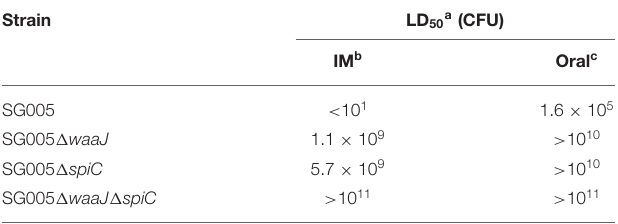
TABLE 1 | Chicken LD 50 for the wild-type SG005 and deletion